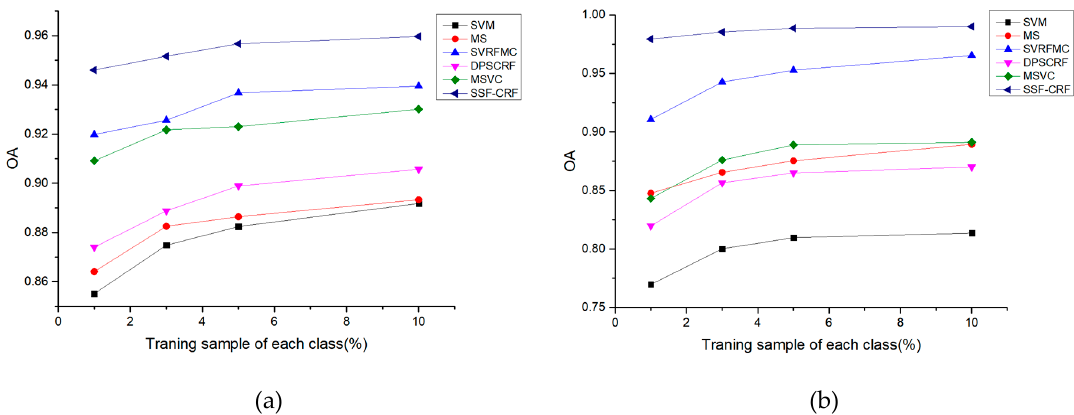
Figure 10. Sensitivity analysis for the training sample size: ( a ) Hanchuan dataset; ( b ) Honghu dataset.